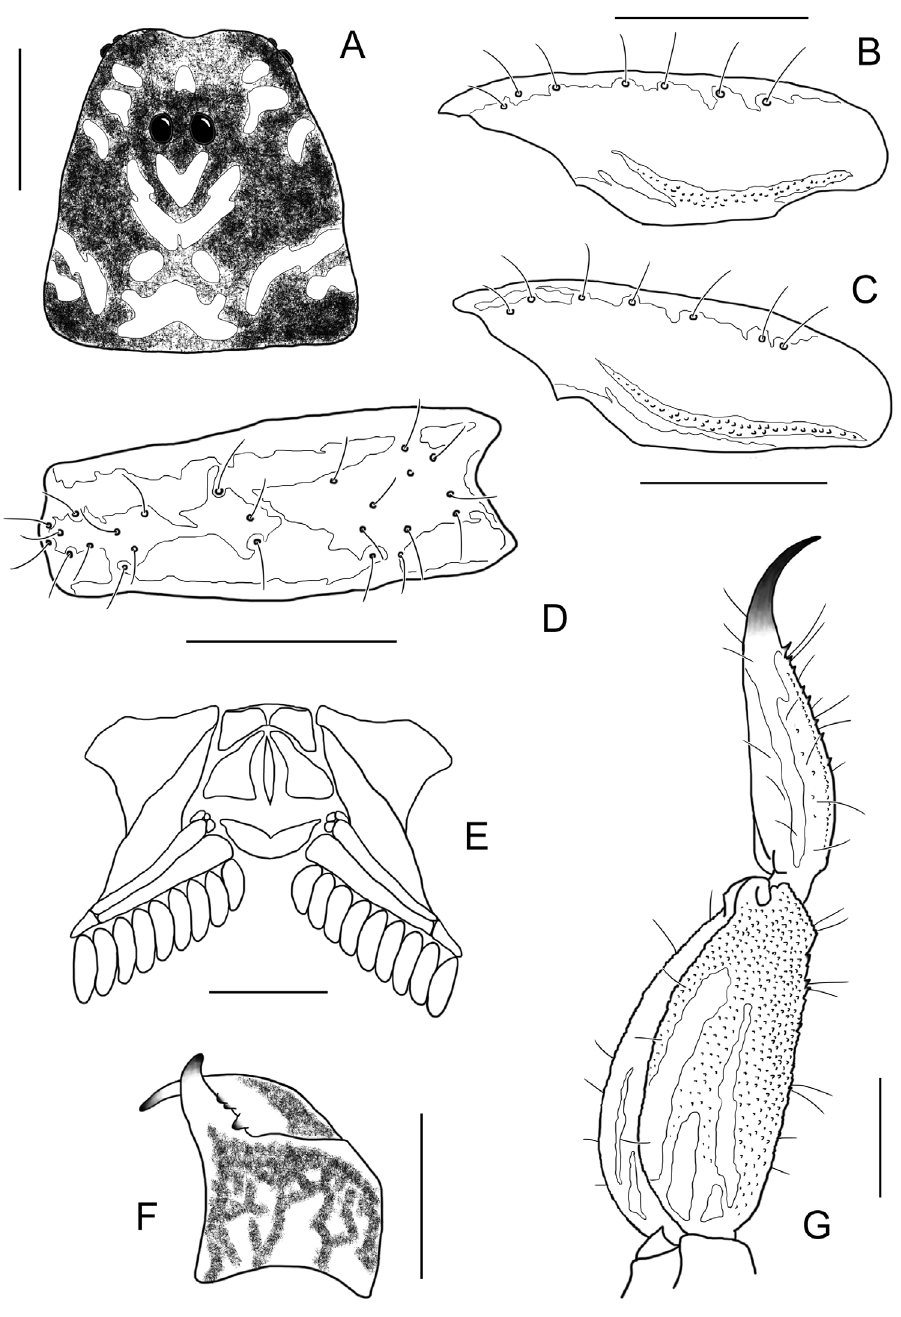
Figure 28. Hadrurochactas cristinae sp. n., male holotype. A Carapace B–C Patella, dorsal aspect of H. cris- tinae ( B ) and H. schaumii ( C ) D Patella, external aspect E Sternum, genital operculum and pectines F Cheli- cera G Metasomal segment V and telson, lateral aspect. Scale bars: 1 mm except chelicera 0.5 mm ( F